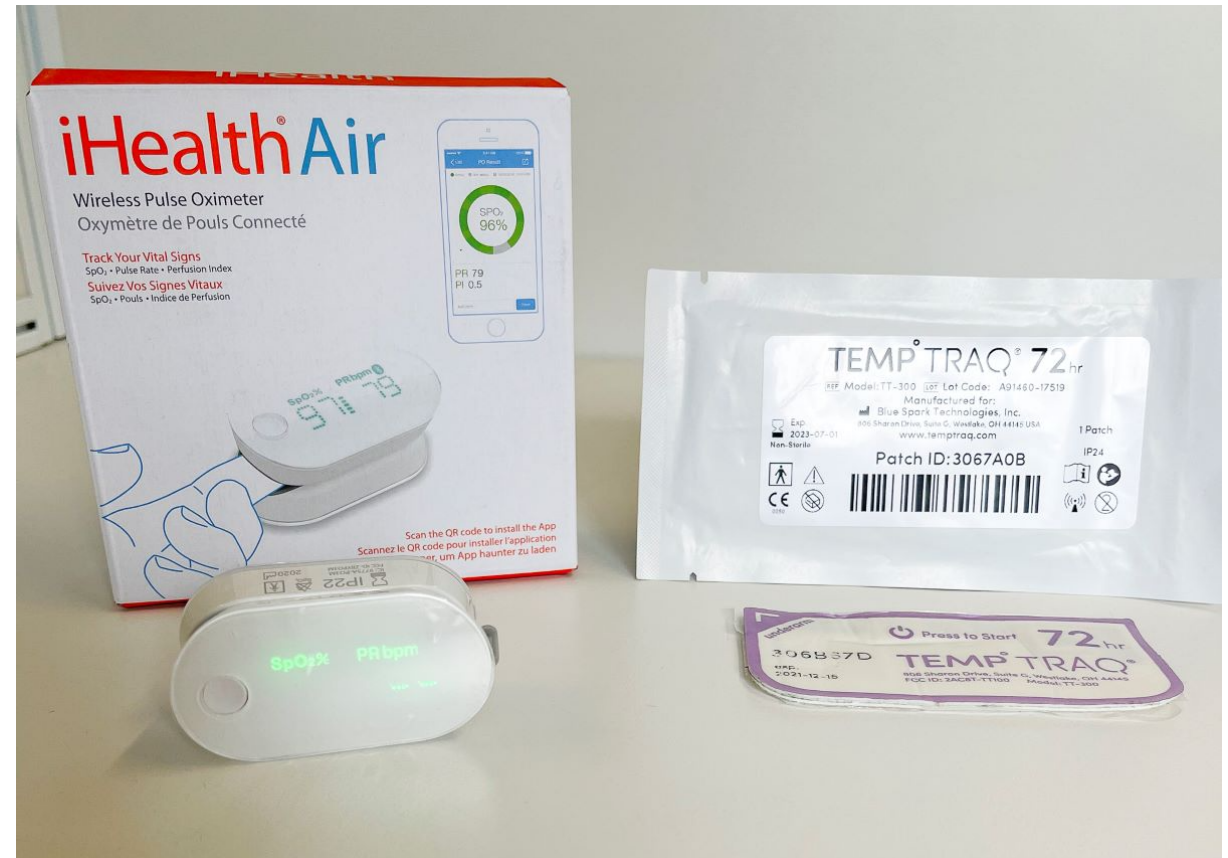
(Figure 1). No reliable device for measuring the respiratory rate was identified; respiratory rate was measured through videoconference consultations. Figure 1. Remote monitoring equipment provided to patients for measurement of pulse, blood oxygen saturation, and temperature.